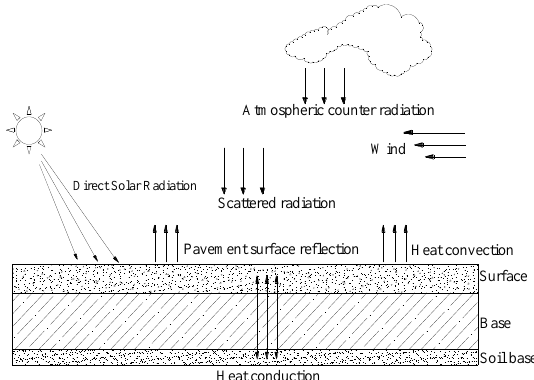
Figure 5. Typical light–heat environment of asphalt pavement.